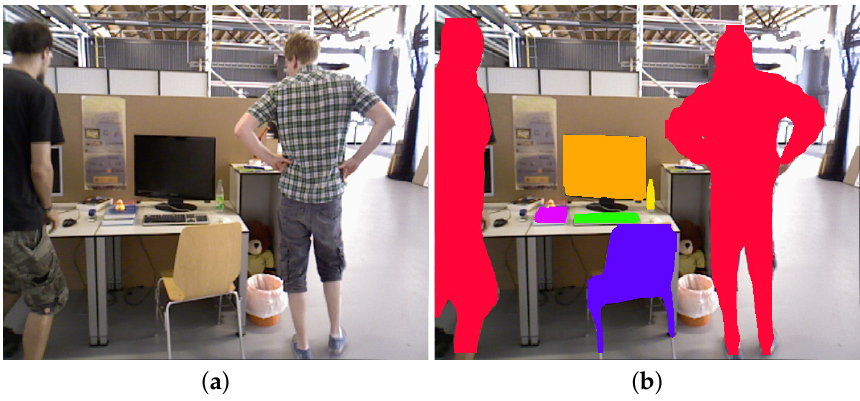
Figure 5. Segmentation effect: ( a ) the raw image; ( b ) semantic segmentation